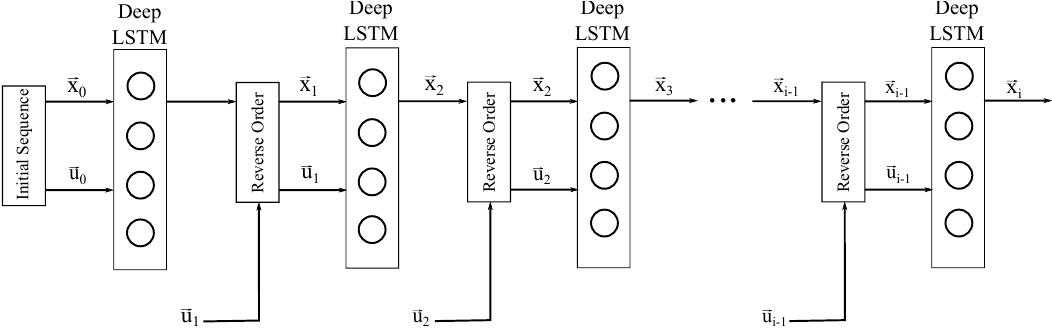
Figure 3. Iterative prediction of the system’s outputs over a long time-horizon. Each “Deep LSTM" receives the predicted sequence of outputs from the previous “Deep LSTM" and an equivalent length of new system’s inputs in reverse order and predict the next sequence of outputs of same time duration in future.